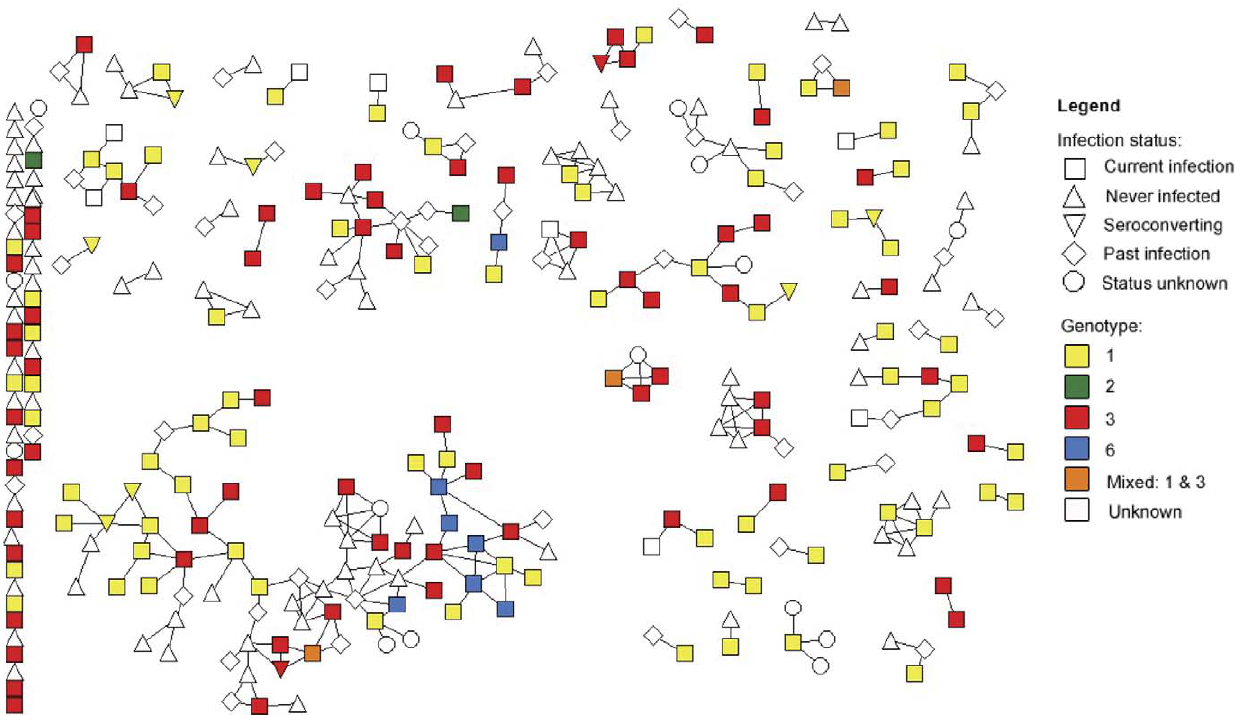
Figure 2. HCV infection status and genotype in the baseline injecting network. Note: The infection status of each participant in the network is denoted by the shape of the node. Amongst participants who were infected at enrolment – that is, infection status is ‘‘current infection’’ or ‘‘seroconverting’’ – genotype is indicated by colour. Nodes that are not coloured represent participants who were not infected at baseline (white upward triangle or diamond) or participants who were infected at baseline but for whom the genotype could not be determined due to insufficient serum and/or low viral load (white square or downward triangle).